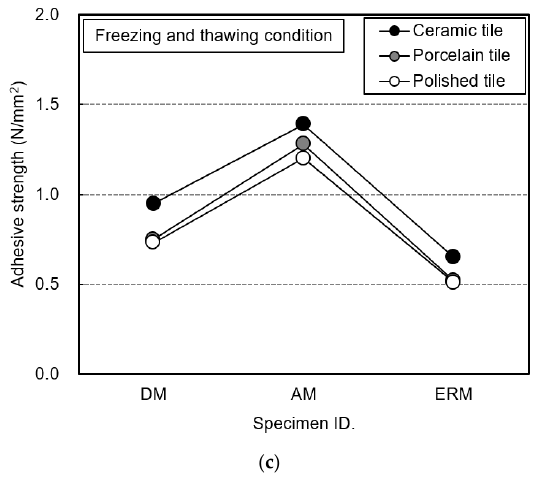
Figure 13. Adhesive strength based on different curing conditions: ( a ) air, ( b ) water, and ( c ) freezing-thawing.